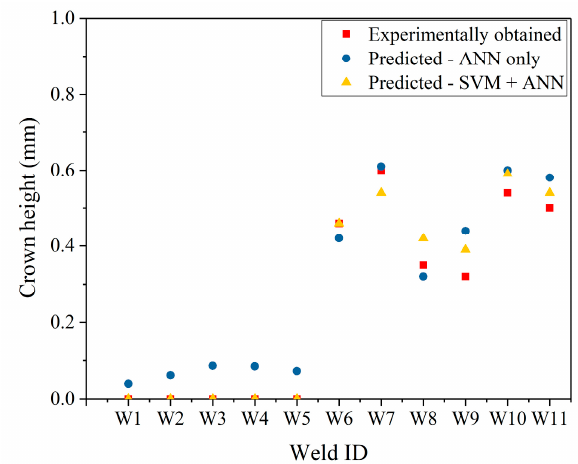
Figure 9. Comparison of the experimentally obtained and predicted CH using the ANN-only and SVM–ANN models for welds W1 to W11 in Table 4.